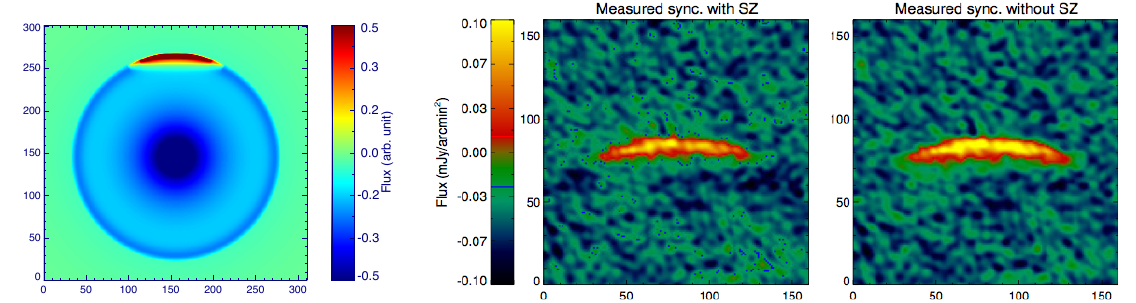
Figure 2. Simulation of the SZ flux contamination for radio relic observations (from [17]). Left: A 2D toy model of the synchrotron and SZ flux distribution in a cluster with a spherical shock front. The SZ signal is shown azimuthally extended beyond the radio synchrotron emission region purely for illustration. Right: A mock but realistic interferometric observation of this radio relic at 10 GHz with and without the SZ effect. The low relic flux measurement in the presence of the SZ signal is evident. (Credit: Basu, K., et al. A&A, 591, A142., 2016, reproduced with permission